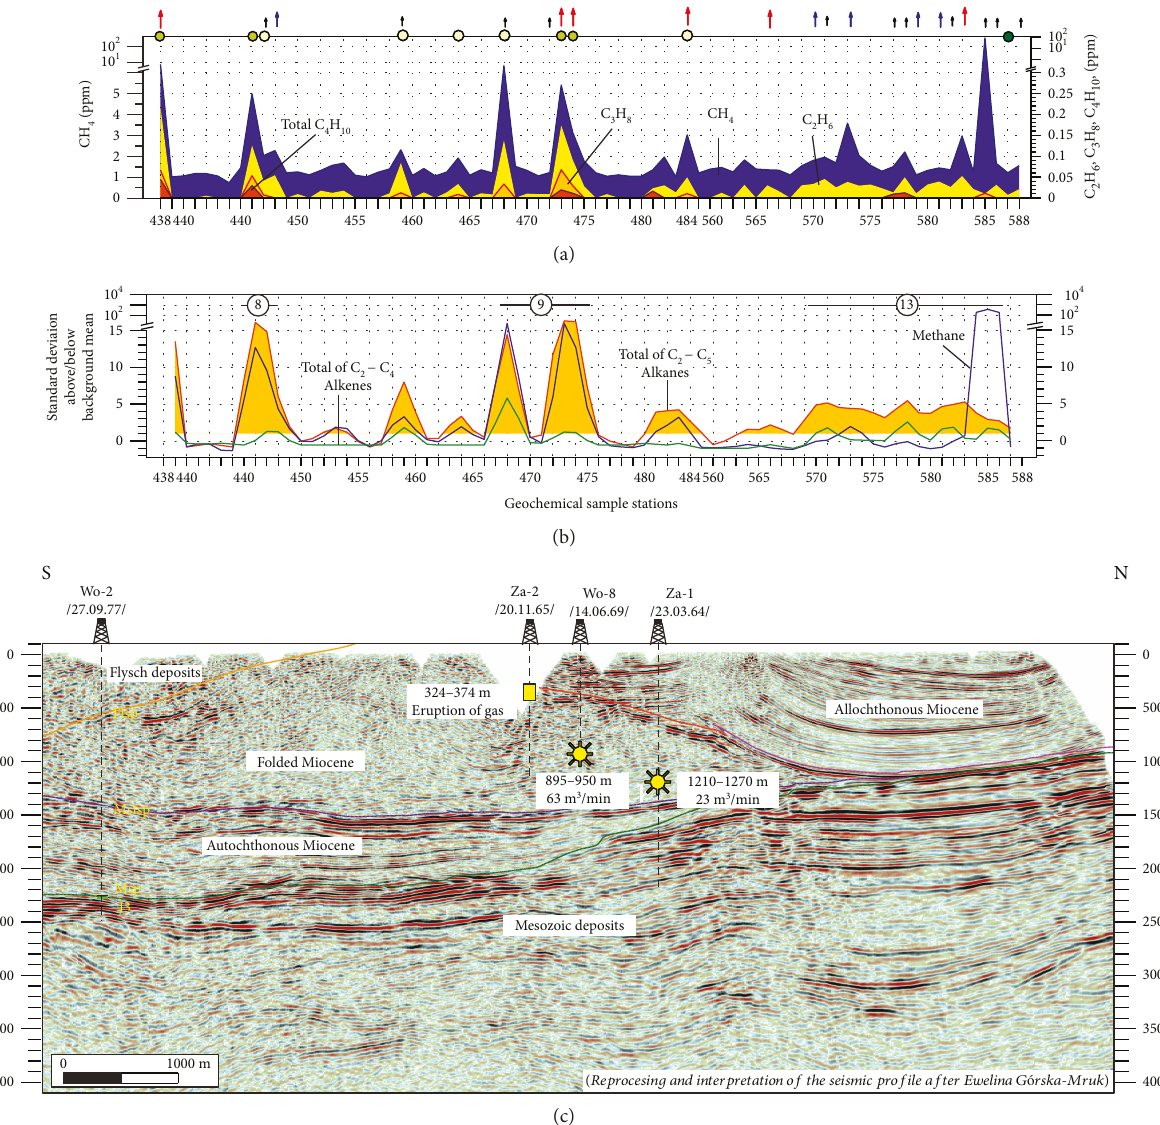
Figure 11: Variations of soil gas geochemistry along the F-F ′ seismic pro fi le (see the location in Figures 1(b) and 9). For explanations, see Figure